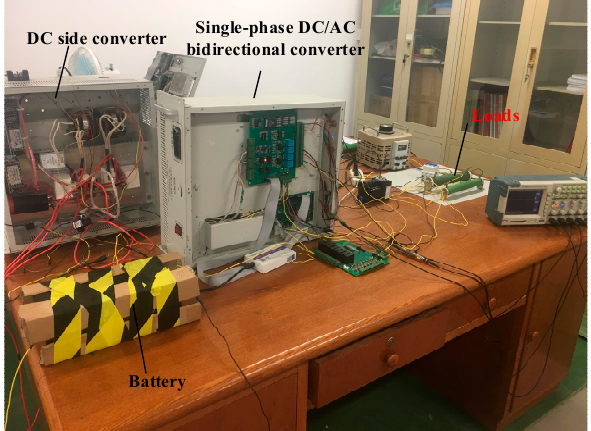
Figure 17. Photo of laboratory prototype of SPEER.